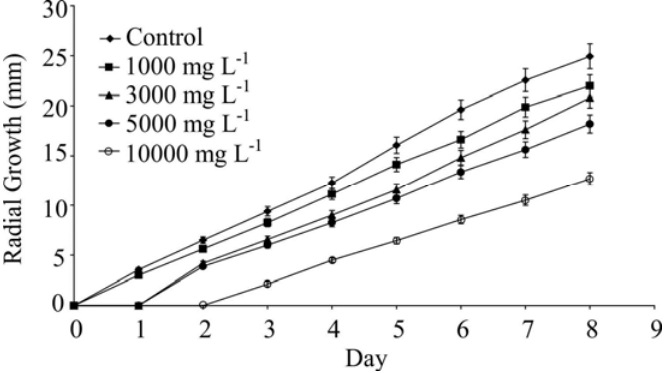
Figure 2. Radial culture growth of C. cassiicola in culture media containing L.